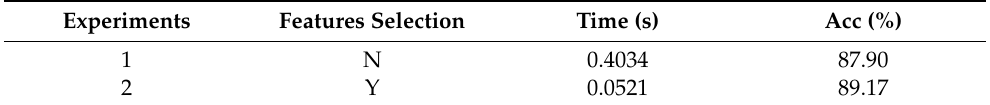
Table 1. Time consuming for before and after feature selection.